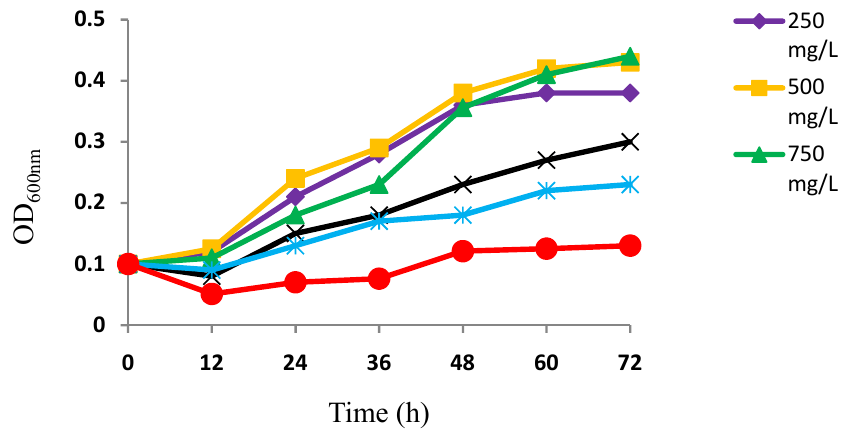
Fig. 3: Bacterial growth of strain O-CH1 in different concentrations of phenol